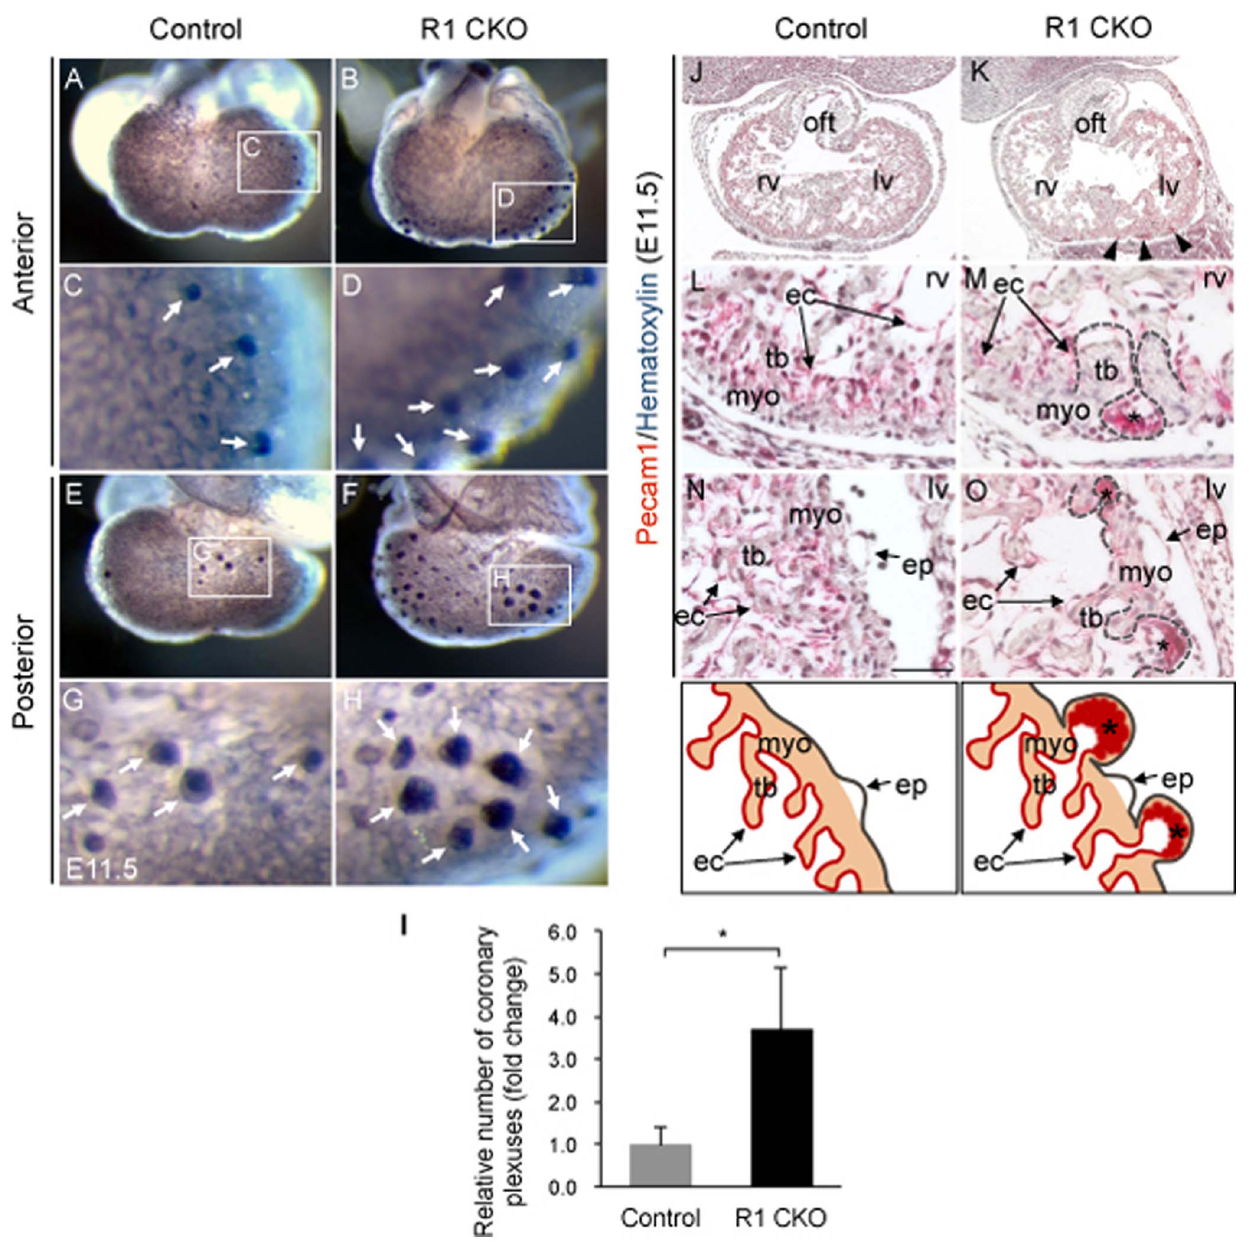
Figure 2. Disruption of Vegfr1 in the endocardium results in the precocious and abnormal coronary plexuses. A–H, Wholemount Pecam1 immunostainings of E11.5 hearts show the newly formed coronary plexuses in the ventricles. Note greatly increased formation of these primitive vessels by the R1 CKO hearts ( B , D , F , H ) compared to the control hearts ( A , C , E , G ). I, Statistic analysis showing the increase is significant. n =7 hearts for each group, * p , 0.05, error bars=SD. J–O, Immunostained frontal sections of E11.5 ventricles with Pecam1 antibodies showing that the precocious coronary plexuses (red staining) in the R1 CKO ventricles are dilated and resemble the primitive blood islands ( K , M , O ; indicated by arrowheads and asterisks), which are not present in the control hearts ( J , L , N ). Dash lines and schematic diagrams showing these early-formed abnormal coronary plexuses within the myocardium of the R1 CKO hearts. ep, epicardium; myo, myocardium; oft, outflow track; lv/rv, left/right ventricle; tb, trabeculae; scale bar =50 m m. doi:10.1371/journal.pone.0070570.g002 (Vector Labs). The color reaction was performed using the Elite Sectional Immunohistochemistry Avidin-Biotin Complex (ABC) kit and DAB Peroxidase Substrate E11.5 whole embryos or E14.5 isolated hearts were fixed in kit (Vector Labs). The stained hearts were photographed using the 4% paraformaldehyde and processed for immunohistochemistry. Zeiss SteREO Discovery V12 stereomicroscope. For each Tissue sections were blocked in PBS containing 3% BSA and embryonic stage, 5 age-matched Vegfr1 f/ + ;Nfatc1 Cre (designated as 0.05% Triton X-100 and incubated with rabbit polyclonal anti- control hereafter) and Vegfr1 f/f ;Nfatc1 Cre embryos (designated as R1 Pecam1 antibodies (Santa Cruz Biotechnology, sc-1506) or a CKO) were used for wholemount Pecam1 immunostaining. rabbit monoclonal anti-Cleaved Caspase3 antibody (Cell